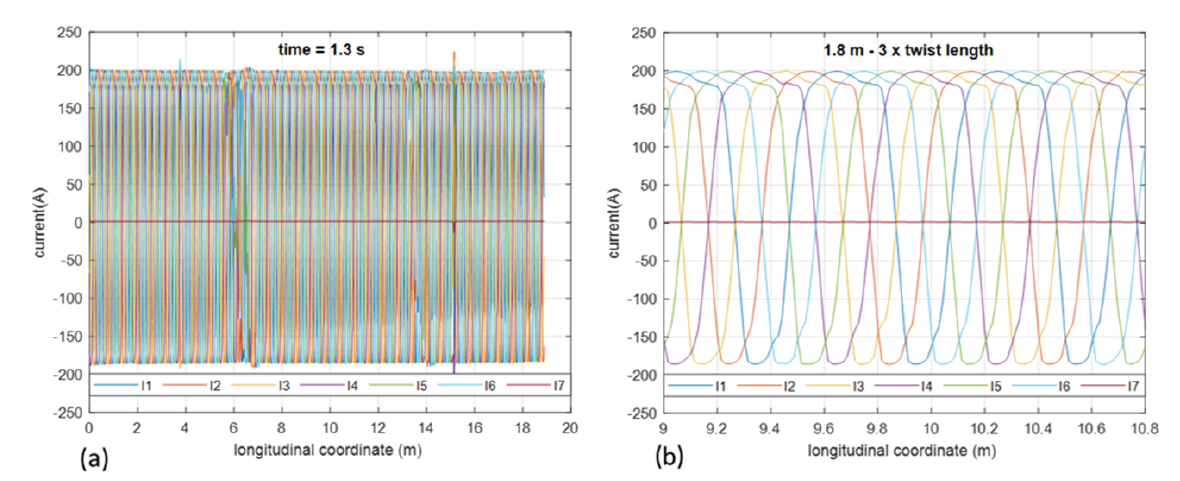
Figure 8. ( a ) Current of the filaments in ten turns at t = 1.3 s. The total current of the coil is 376.3 A. ( b ) detail of the current over a conductor length of three twist pitches (3 × 0.6 m) at the middle of the ten turns. Currents denoted from I 1 to I 6 are the currents of the superconductor filaments. Current I 7 is the current of the copper strip.